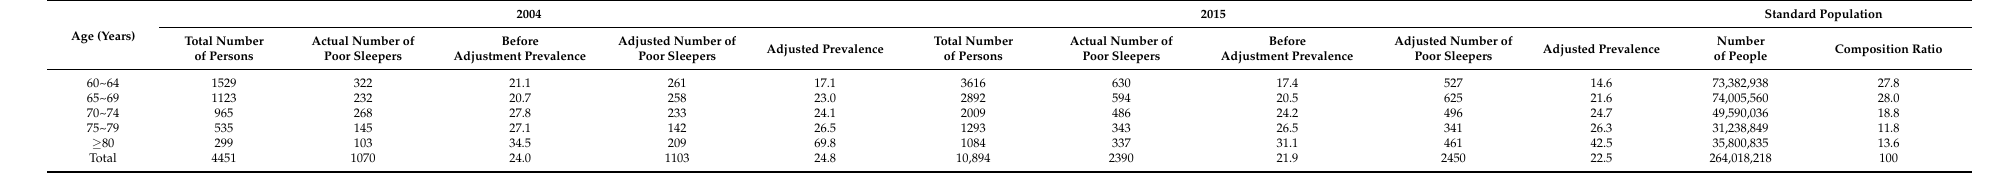
Table 2. 1-month prevalence of poor sleep quality in a sample aged 60 years or older from Shandong in China between 2004 and 2015 ( n , %).